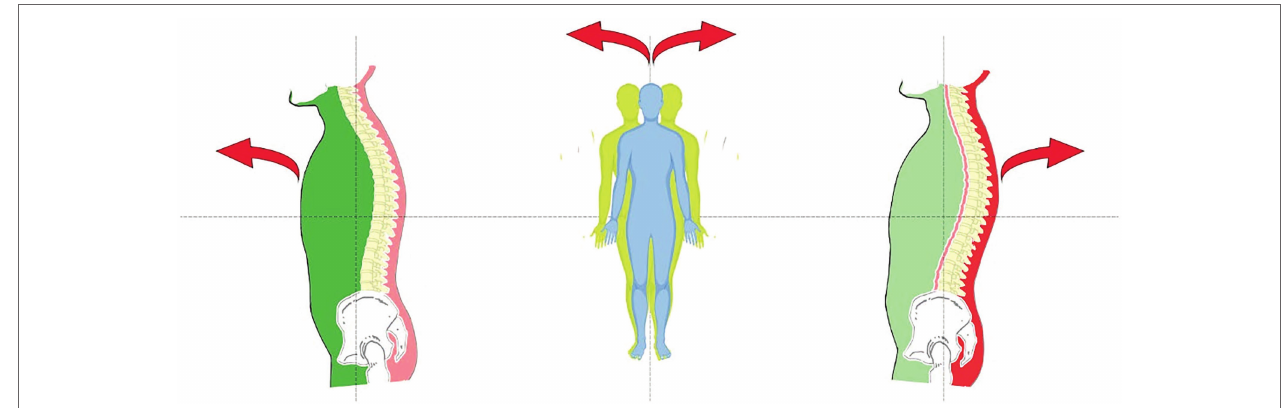
FIGURE 2 | Visceral Pattern (Green) – Meningeal/Cranial Pattern (Yellow) – Postural/muscle skeletal pattern